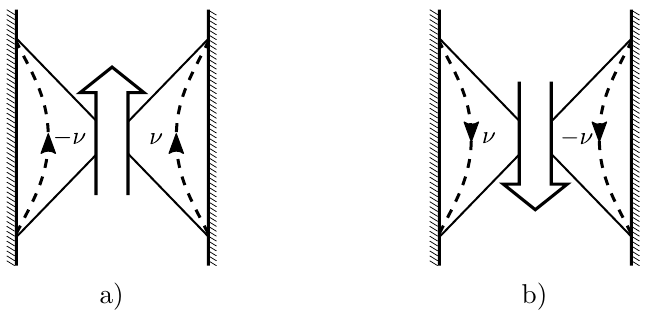
Figure 4 . a,b) The time with respect to which matter (cid:12)elds should be quantized, determined by the direction of propagation for (cid:23) - and ( (cid:0) (cid:23) )-particles on opposite sides. which for both signs realize the irrep C (cid:22) and respectively span (cid:21)